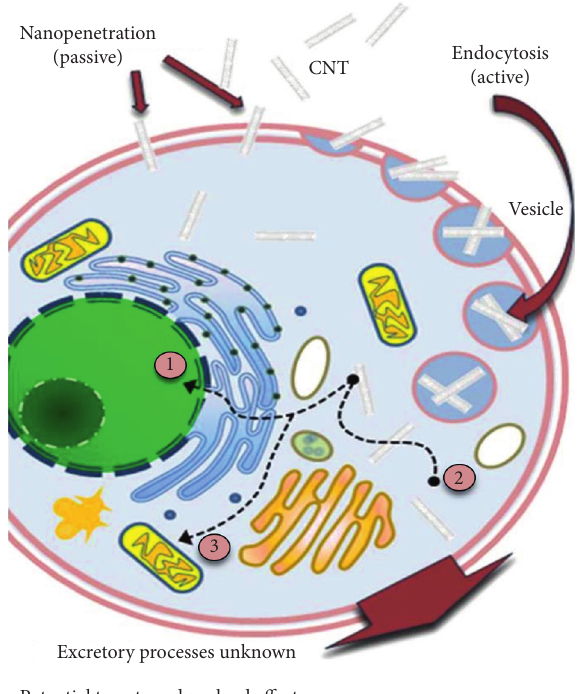
Figure 11: Schematics showing endocytosis and nanopenetration mechanisms of stand-alone CNTs